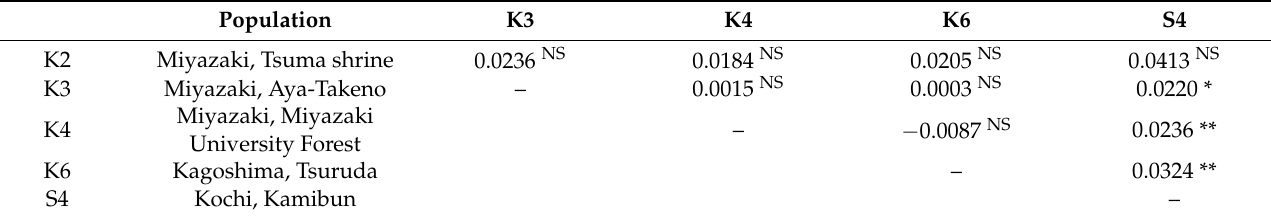
Table 4. Pairwise F ST estimated from microsatellite loci for Q. glauca .